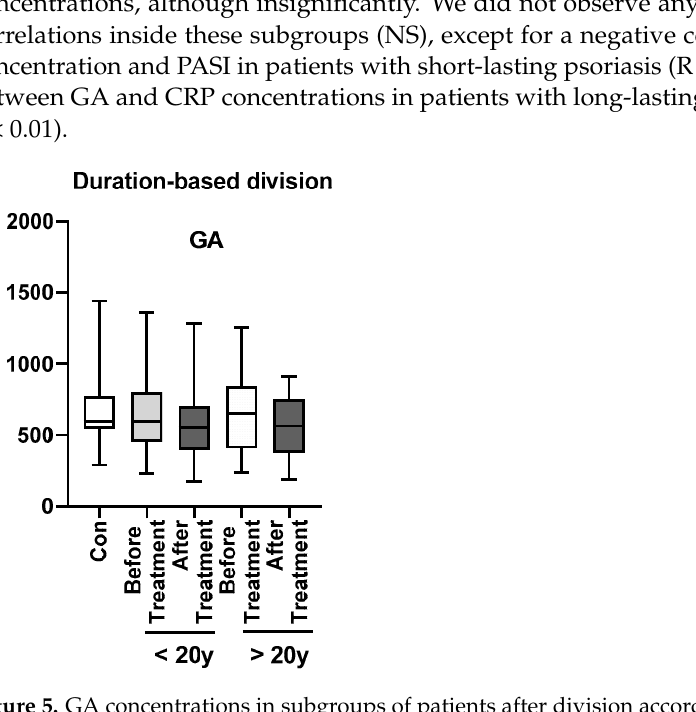
Figure 5. GA concentrations in subgroups of patients after division according to the duration of the dermatosis–less or more than 20 years, with division before and after the treatment.